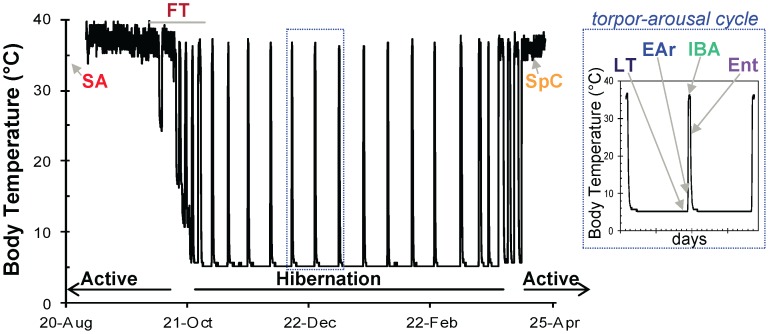
Sampled states of the hibernator’s year were defined by body temperature.Samples were collected from 7 states. Summer (SA, n = 6) and spring (SpC, n = 5) ground squirrels represented the homeothermic portions of the annual cycle. Winter states representing the heterothermic period (blue box, expanded for clarity) were collected throughout the winter hibernation season and were defined as follows by body temperature telemetry: entering torpor (Ent, n = 7) at 27°C>Tb >23°C; late torpor (LT, n = 7) at 80–95% previous bout duration; early arousing (EAr, n = 6) at 7°C<Tb <12.8°C; and 3–4 hours after Tb stabilized in inter-bout arousal (IBA, n = 5) period. Samples were also collected during the highly variable Fall transition period (FT, n = 12) [16]. Colors representing each state are used throughout.